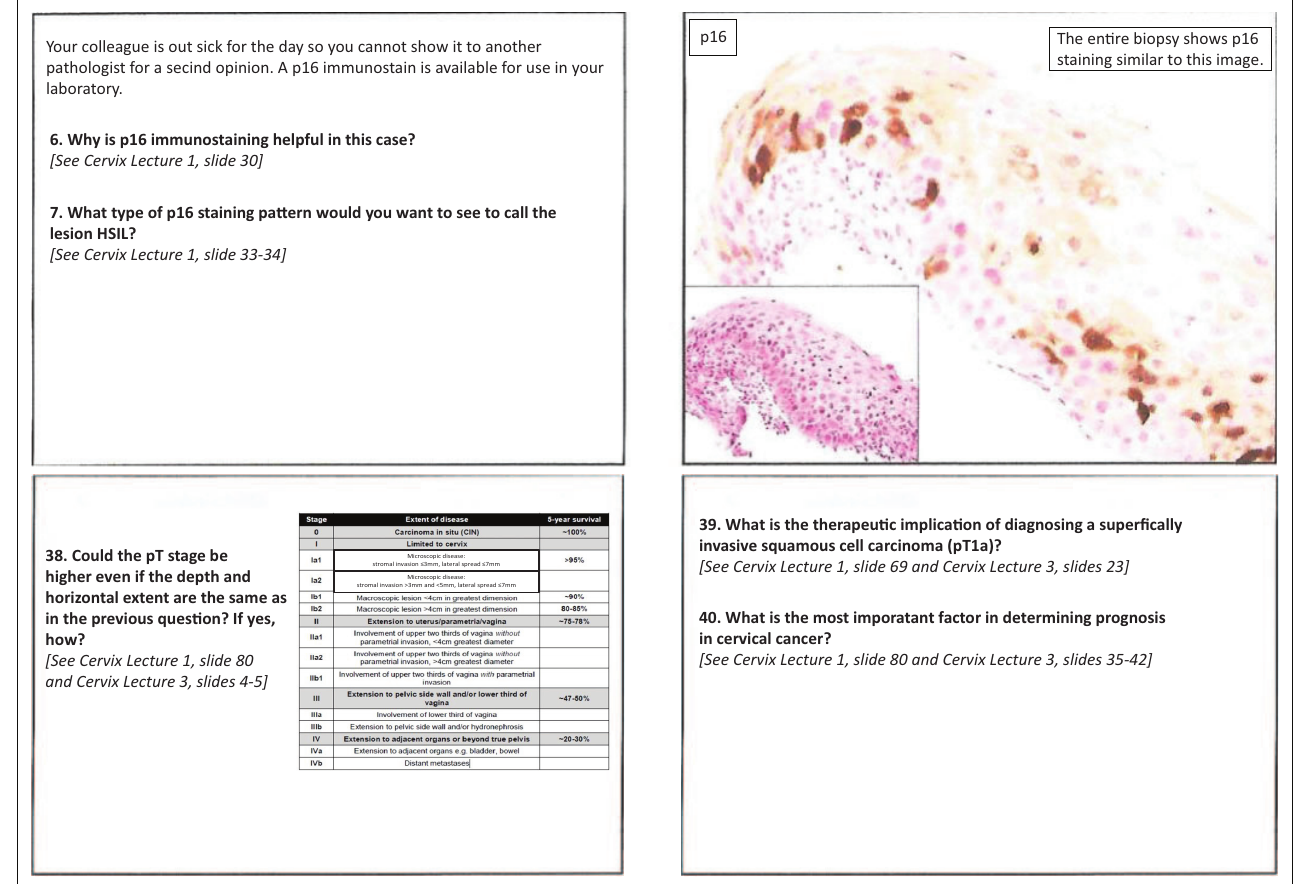
Supplementary Figure 2 (Continues...): Examples of PowerPoint slides printed for pilot testing